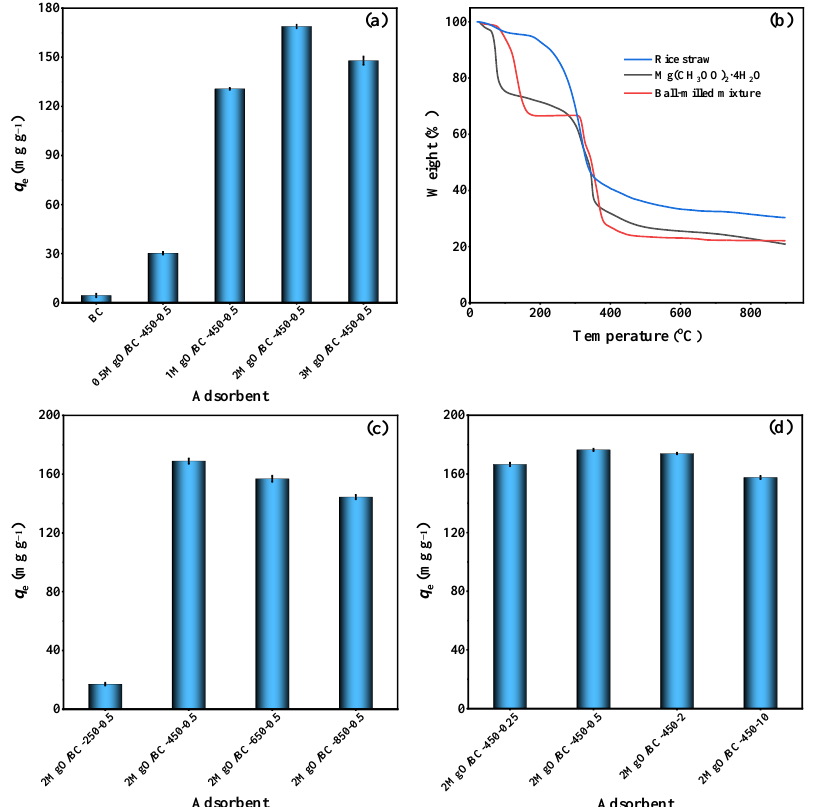
Figure 1. ( a ) Phosphorus adsorption on biochars prepared with different Mg precursor-to-rice straw mass ratios. ( b ) TGA curves of rice straw, Mg(CH 3 COO) 2 ·4H 2 O and ball-milled mixture of straw mass ratios. ( b ) TGA curves of rice straw, Mg(CH 3 COO) 2 · 4H 2 O and ball-milled mixture Mg(CH 3 COO) 2 ·4H 2 O and rice straw. ( c , d ) Phosphorus adsorption on MgO-modified biochars pre- pared at different pyrolysis temperatures and different ball milling times. of Mg(CH 3 COO) 2 · 4H 2 O and rice straw. ( c , d ) Phosphorus adsorption on MgO-modified